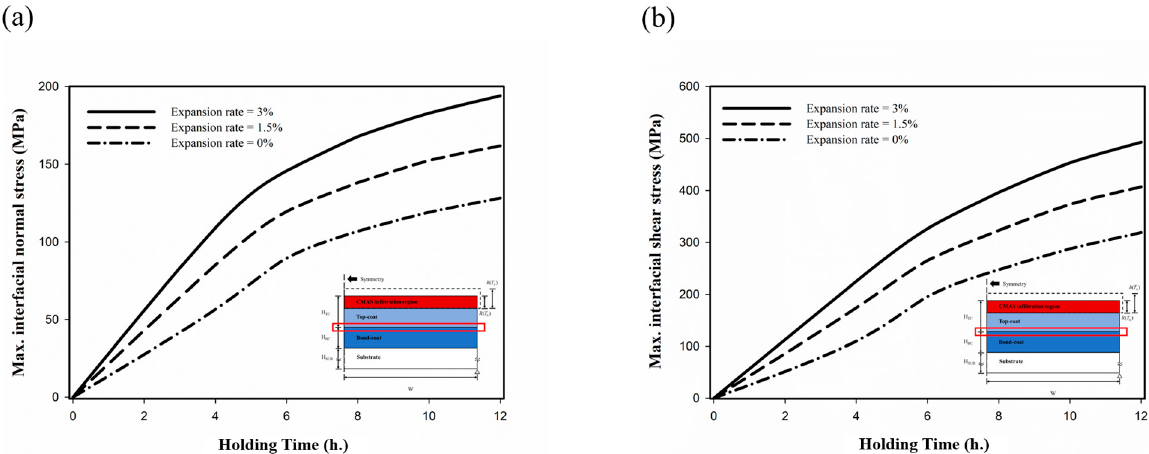
Figure 8. Interfacial stress between topcoat and bond coat due to CMAS infiltration for different holding times with three different expansion rates: ( a ) max. interfacial normal stress; ( b ) max. shear normal stress